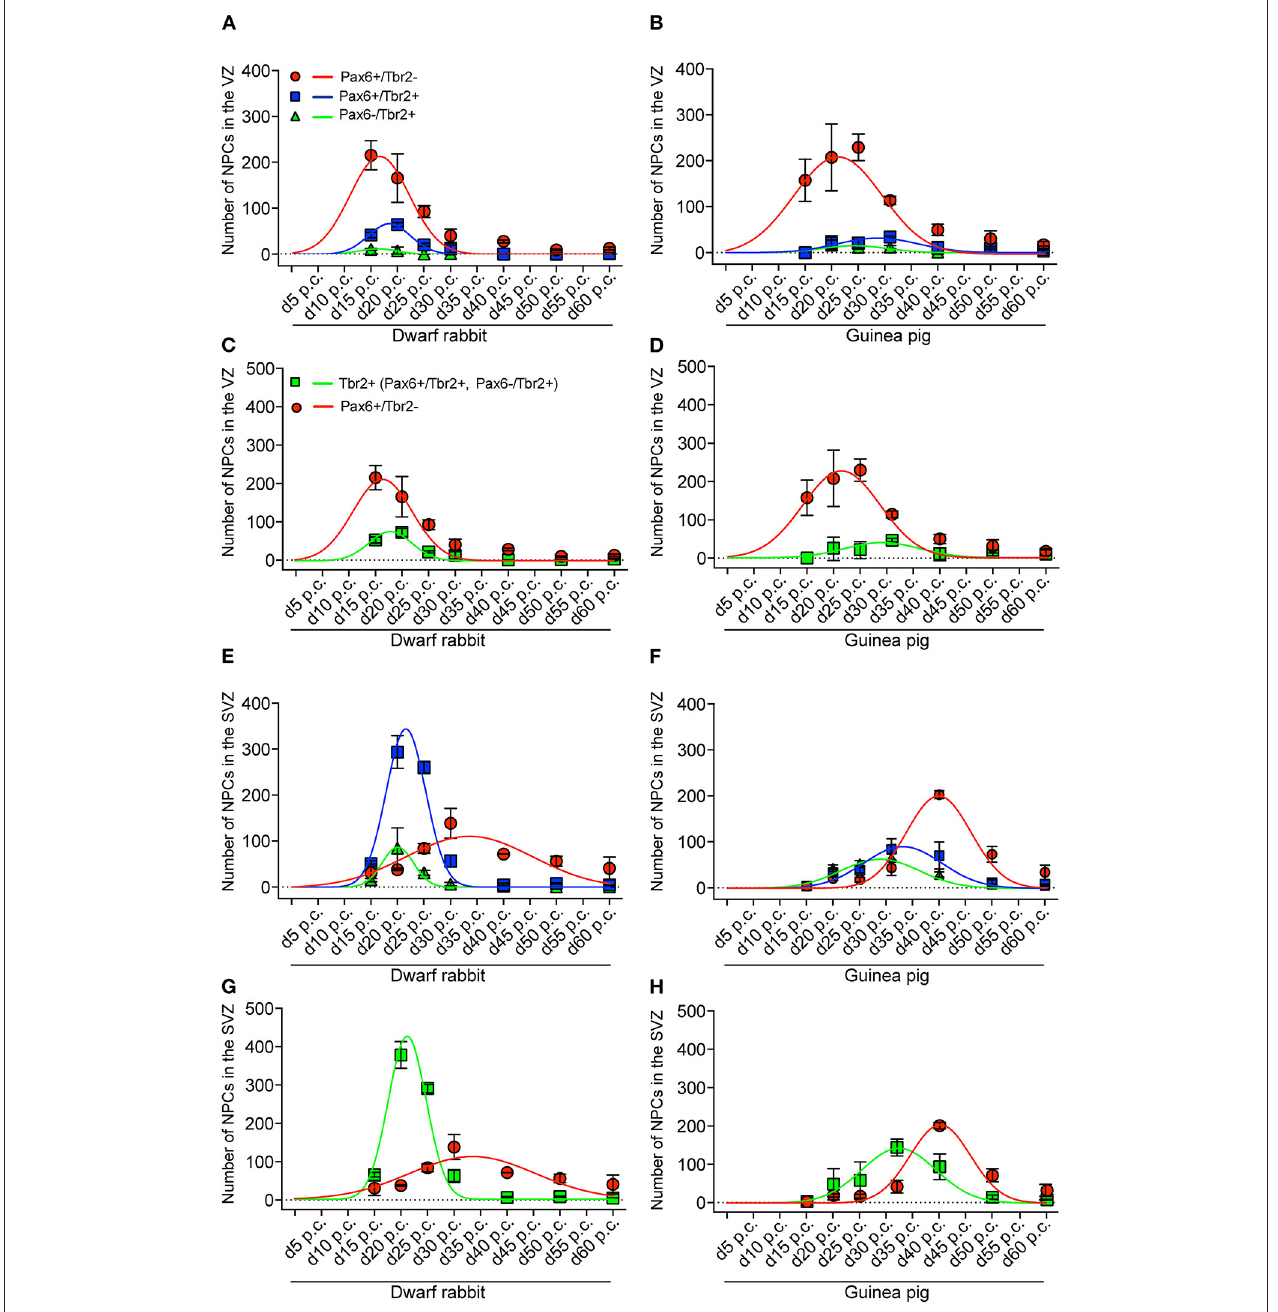
FIGURE 4 | Extrapolation of NPCs abundance in the VZ and SVZ of the developing guinea pig and dwarf rabbit neocortex. (A,B) Pax6 + /Tbr2– (red circles), Pax6–/Tbr2 + (green triangles), and Pax6 + /Tbr2 + (blue rectangles) NPCs in the VZ of day 15 to 60 post conception (p.c.) dwarf rabbit and guinea pig neocortex, expressed as number of cells per 100 µ m ventricular surface. Color legend is shown in (A) . (C,D) Pax6 + /Tbr2– (red circles) and Tbr2 + (Pax6–/Tbr2 + , Pax6 + /Tbr2 + , green rectangles) NPCs in the VZ of day 15 to 60 post conception (p.c.) dwarf rabbit and guinea pig neocortex, expressed as number of cells per 100 µ m ventricular surface. Color legend is shown in (C) . (E,F) Pax6 + /Tbr2– (red circles), Pax6–/Tbr2 + (green triangles), and Pax6 + /Tbr2 + (blue rectangles) NPCs in the SVZ of day 15 to 60 post conception (p.c.) dwarf rabbit and guinea pig neocortex, expressed as number of cells per 100 µ m ventricular surface. Color legend is shown in (A) . (G,H) Pax6 + /Tbr2– (red circles) and Tbr2 + (Pax6–/Tbr2 + , Pax6 + /Tbr2 + , green rectangles) NPCs in the SVZ of day 15 to 60 post conception (p.c.) dwarf rabbit and guinea pig neocortex, expressed as number of cells per 100 µ m ventricular surface. Color legend is shown in (C) . (A–H) Data were obtained as in Figure 3 . Development of NPCs in the VZ and SVZ was extrapolated based on Gaussian distribution. For details, see Materials and Methods section. (A) red line, R 2 = 0.8964; green line, R 2 = 0.6911; blue line, R 2 = 0.9572; (B) red line, R 2 = 0.8849; green line, R 2 = 0.6944; blue line, R 2 = 0.7487; (C) red line, R 2 = 0.8964; green line, R 2 = 0.9424; (D) red line, R 2 = 0.8893; green line, R 2 = 0.5212; (E) red line, R 2 = 0.5694; green line, R 2 = 0.7891; blue line, R 2 = 0.9844; (F) red line, R 2 = 0.9426; green line, R 2 = 0.9190; blue line, R 2 = 0.8249; (G) red line, R 2 = 0.5694; green line, R 2 = 0.9868; (H) red line, R 2 = 0.9398; green line, R 2 = 0.7716.